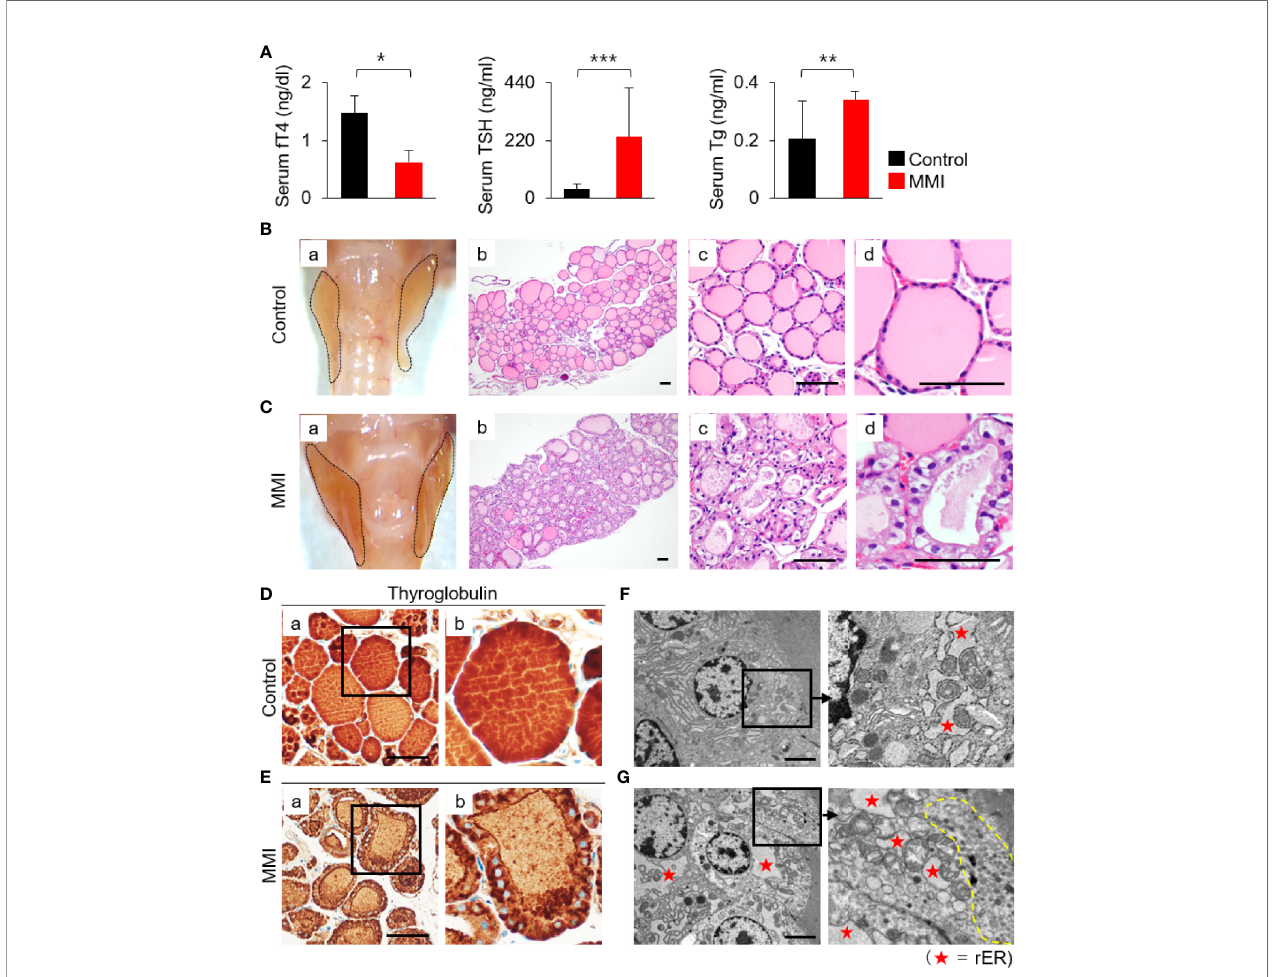
FIGURE 1 | Histopathological characterization and functional activity of thyroid in MMI-treated mice. (A) Serum fT4 levels were markedly lower in MMI-treated mice than in control mice ( P = 0.032). In addition, serum TSH levels in MMI-treated mice were signi fi cantly higher ( P = 0.00004), indicating that primary hypothyroidism in mice was properly induced by MMI treatment. Serum Tg levels were signi fi cantly higher in MMI-treated mice ( P = 0.005). * P < 0.05; ** P < 0.01; *** P < 0.001. The size of the thyroid gland was larger in MMI-treated mice than controls (B-a, C-a) . (B) H&E-stained sections of the control thyroid gland showed round/ovoid follicles containing homogeneous colloids that were regularly distributed. Scale bar, 25 m m. (C) In the thyroid of MMI-treated mice, irregularly shaped follicles, consisting of enlarged follicular cells with cytoplasmic vacuoles, had reduced luminal colloids. H&E staining. Scale bar, 25 m m. (D, E) Follicular cell activity was analyzed by comparing the concentration of colloid Tg between the thyroid of MMI-treated mice and control groups. Scale bar, 25 m m. (F, G) Transmission electron micrographs of thyroid glands containing distended cisternae of the rough endoplasmic reticulum (rER, as indicated by star), as well as numerous endocytic vesicles and electron- dense lysosomes (indicated by dotted line) under the apical plasma membrane, from thyroid follicular cells of MMI-treated mice. Scale bar, 2 m